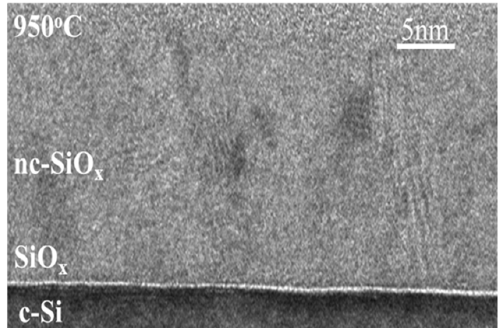
Figure 2. Cross-section TEM images of nc-SiO x and ultrathin (~1.2 nm) SiO 2 layer.